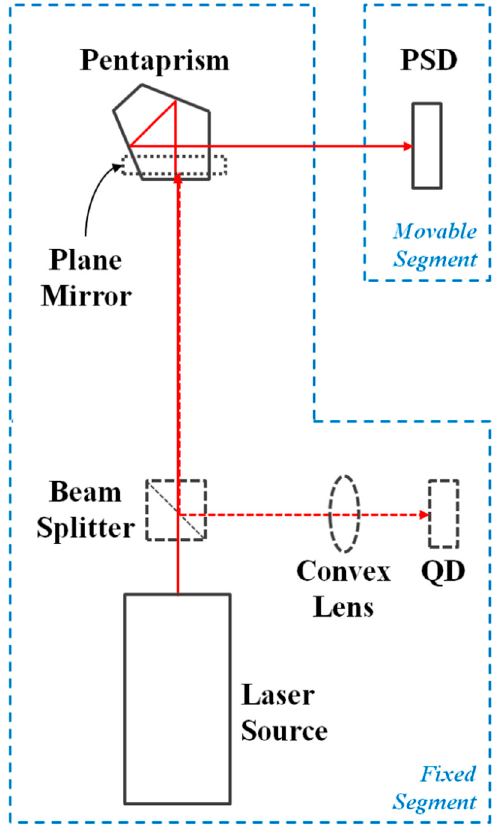
Figure 1. System optical arrangement.